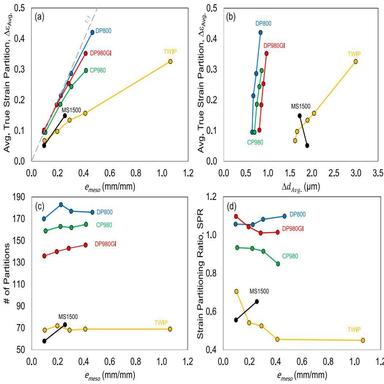
A summary of the average strain partitioning data for (a) ΔεAvg. vs. emeso (b) ΔεAvg. vs. ΔdAvg. (c) # of Partitions (/100 μm) vs. emeso and (d) SPR vs. emeso.